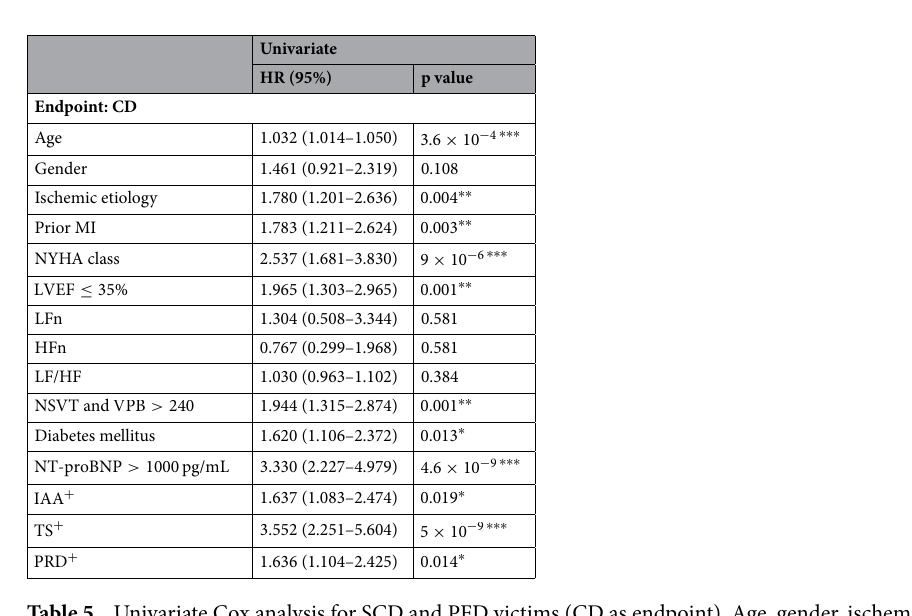
Table 5. Univariate Cox analysis for SCD and PFD victims (CD as endpoint). Age, gender, ischemic etiology, prior myocardial infarction, NYHA class, LVEF, HRV indices (LFn, HFn, LF/HF), combined NSVT and